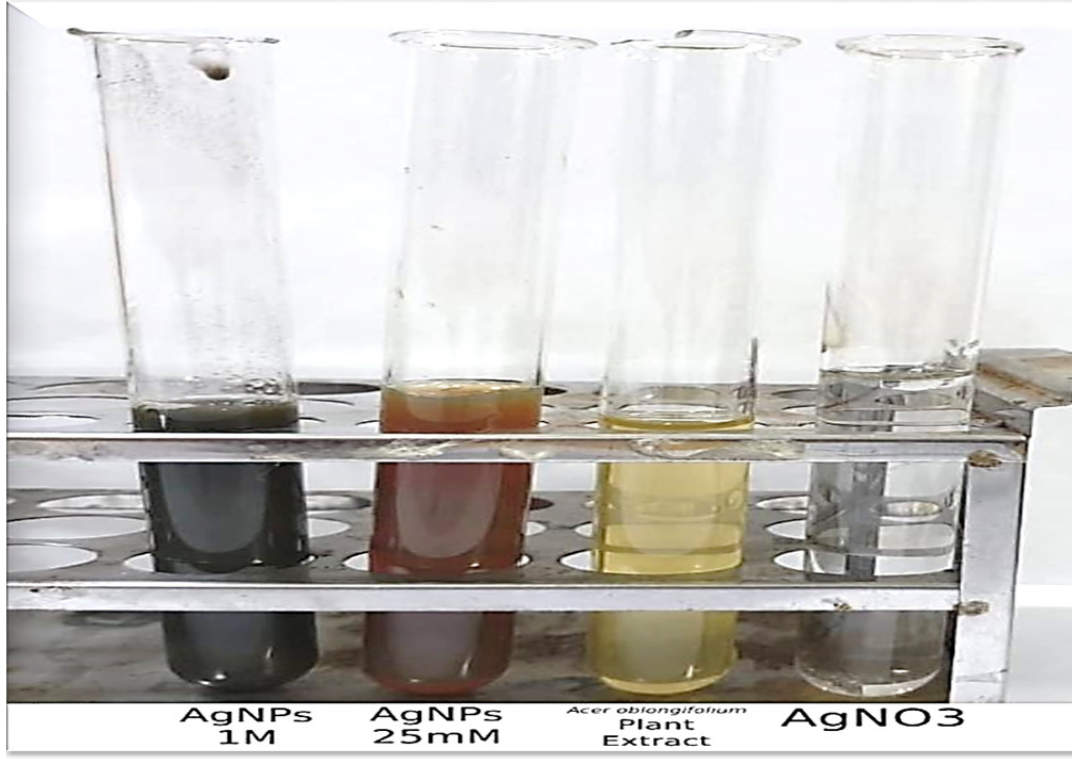
Figure 1. Synthesis of the silver nanoparticles indicated by color change.